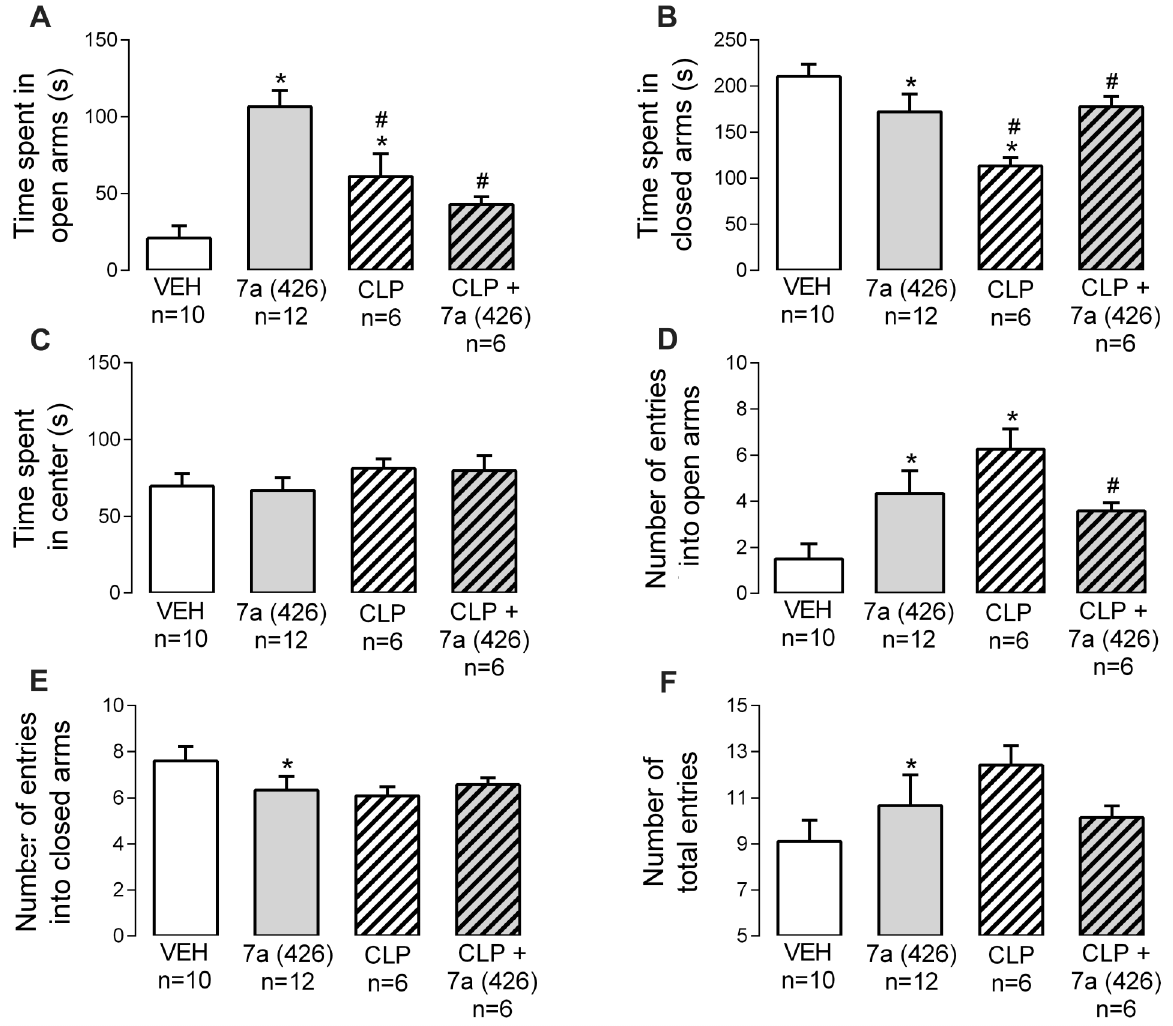
Figure 7. Contribution of dopaminergic receptors (as revealed by the antagonism with chlorpromazine) to the anxiety-like effect evoked by Bj-PRO-7a in the elevated plus maze. A , Time spent in open arms; B , Time spent in closed arms; C , Time spent in center; D , Number of entries into open arms; E , Number of entries into closed arms; F , Number of total entries. Experimental groups: VEH: vehicle (0.9% NaCl); 7a (426): Bj-PRO-7a (426 nmol/kg); CLP: chlorpromazine (2 mg/kg); CLP + 7a (426): co-administration of CLP and Bj-PRO-7a (426 nmol/kg). Data are reported as mean ± SE. *P o 0.05 vs vehicle; # P o 0.05 vs 7a (426) (one-way analysis of variance followed by Fisher ’ s post hoc